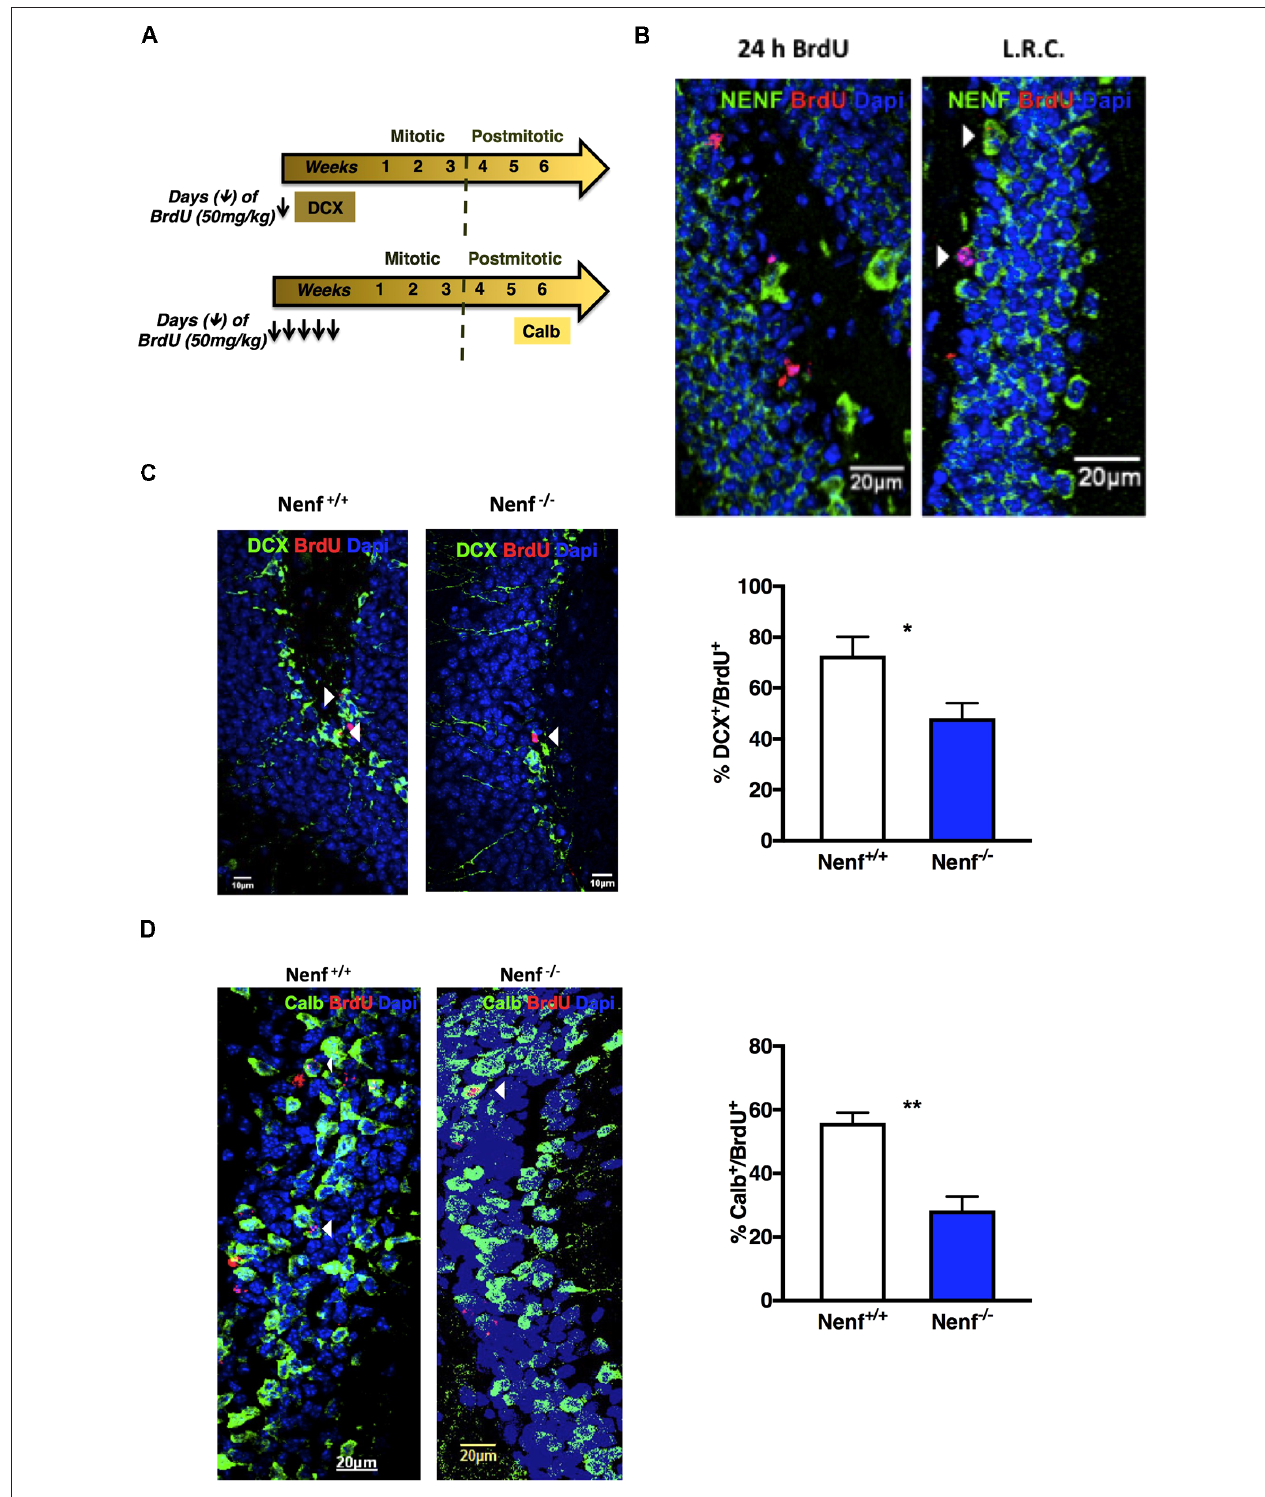
FIGURE 3 | Ablation of NENF impairs neural committed cell proliferation, survival and maturation in the adult hippocampus. Schematic representation of hippocampal neurogenesis chronology and 5-bromo-2 (cid:48) -Deoxyuridine (BrdU) protocol, including specific markers for cellular types (A) . NENF is not expressed in 24 h labeled BrdU neuroblasts, its expression appears later in newly born granular neurons, as seen with NENF (green) and BrdU label retaining cells (LRC) for 7 weeks